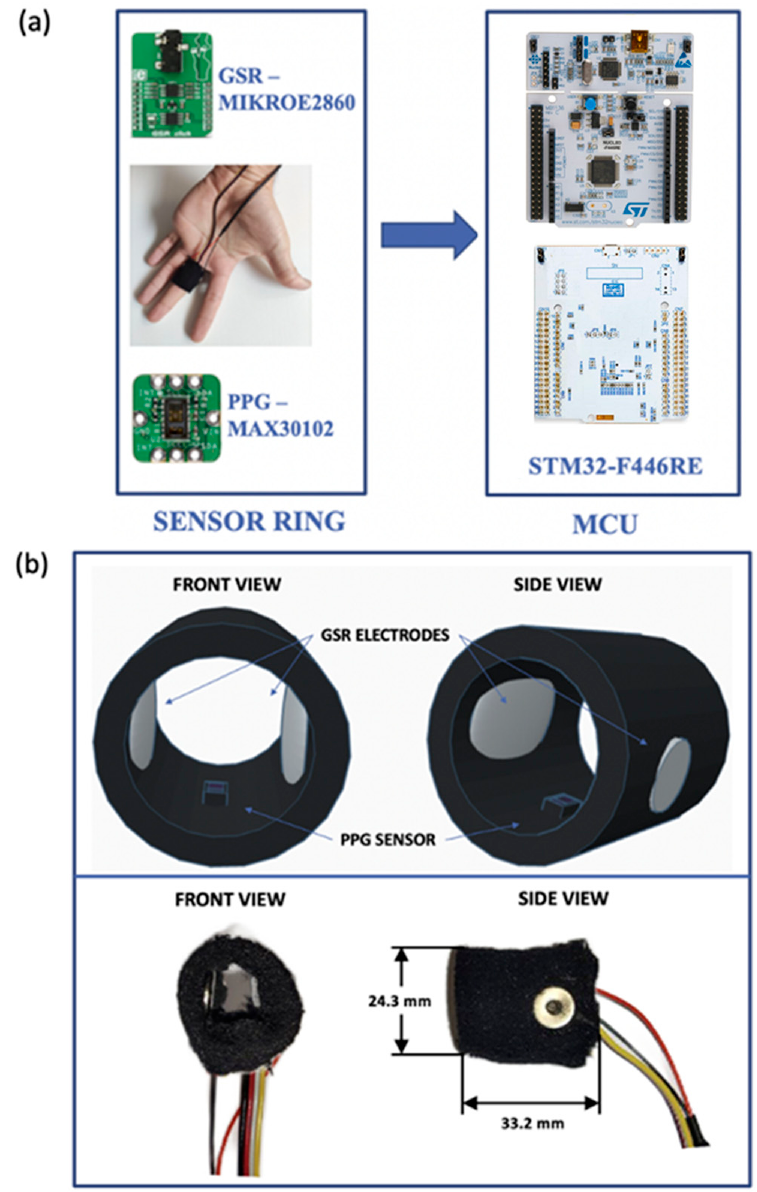
Figure 1. ( a ) Block diagram of the acquisition system. Both PPG and GSR electrodes were placed inside the elastic band (sensor ring) and transferred the data to the microcontroller unit (MCU). ( b ) Front and side views of the design ( top ) and implementation ( bottom ) of the proposed ring-shaped probe, including its dimensions.